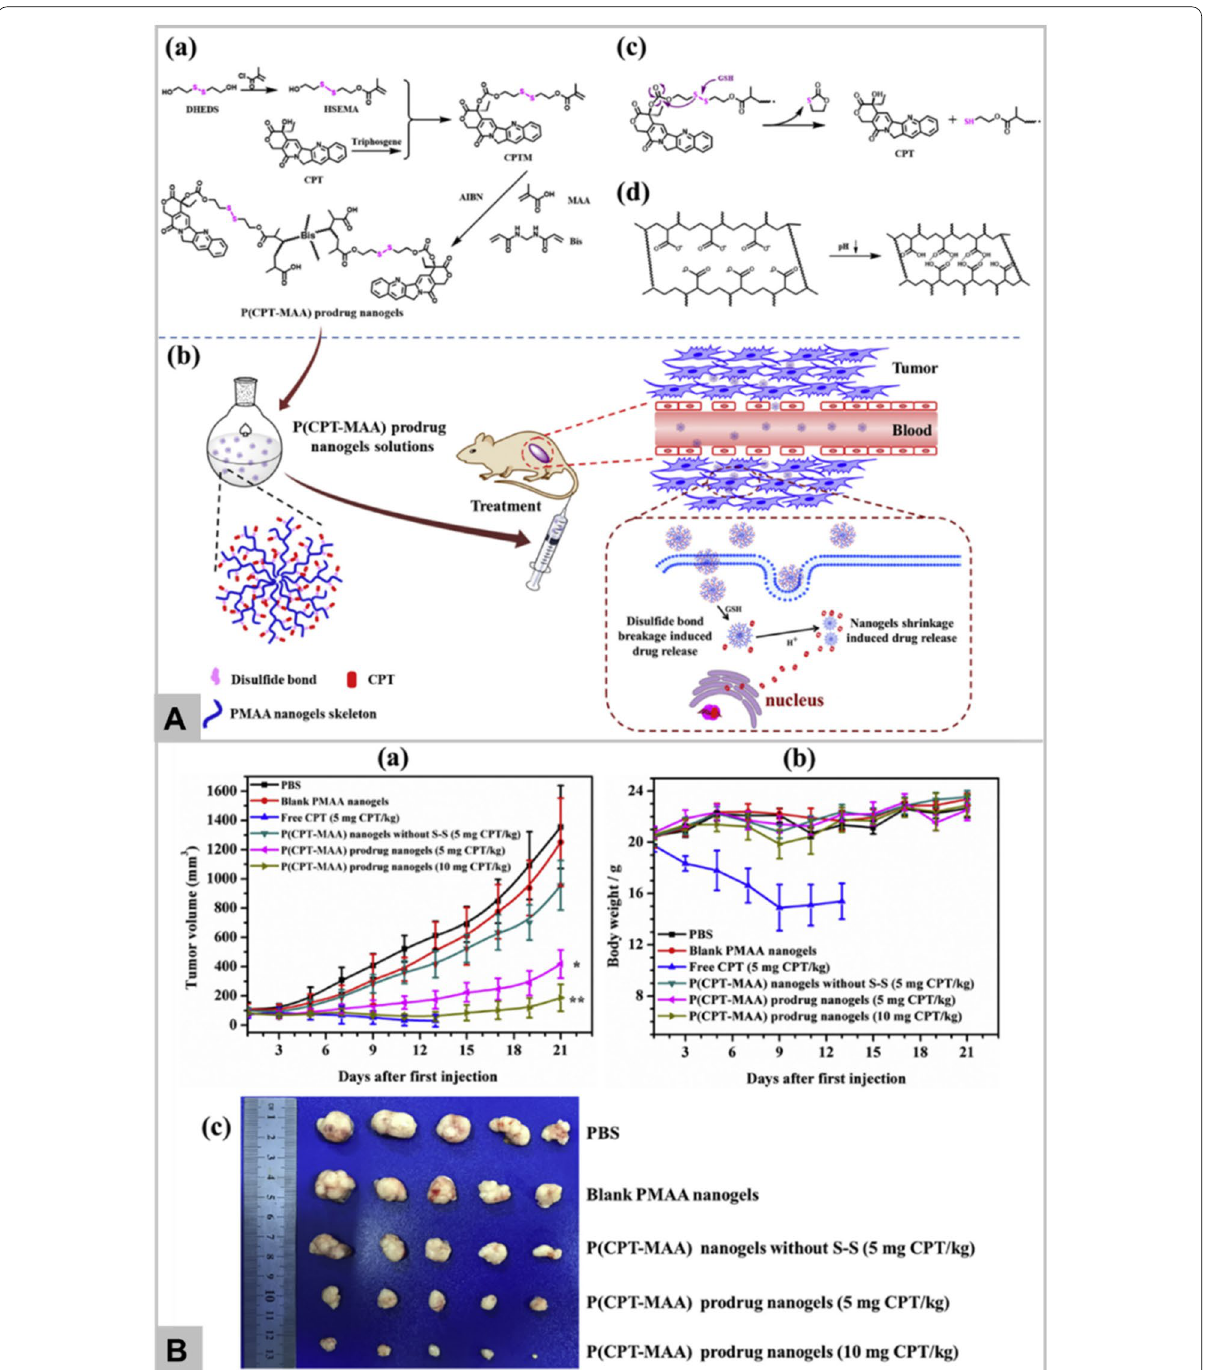
Fig. 10 a Synthesis of the P(CPT-MAA) prodrug nanogels, b Schematic illustration of the pH and redox dual responsive drug release of P(CPT-MAA) prodrug nanogels, c The redox-responsive drug release mechanism, d The pH-responsive mechanism (Panel A ). In vivo antitumor assays. a Relative tumor volume and b body weight of the Hep G2 tumor-bearing BALB/c nude mice administrated by the intravenous injection of PBS, blank PMAA nanogels, free CPT (5 mg CPT/kg), P(CPT-MAA) nanogels without single bond (5 mg CPT/kg), and P(CPT-MAA) prodrug nanogels (5 mg CPT/kg and 10 mg CPT/kg), respectively. c Photo images of the harvested tumors at 21 days post the first injection, no tumor of free CPT group obtained due to the death of all mice at 13 days. *, p < 0.05; **, p < 0.01, compared with PBS, Blank PMAA groups (Panel B ). Reprinted with permission from Journal